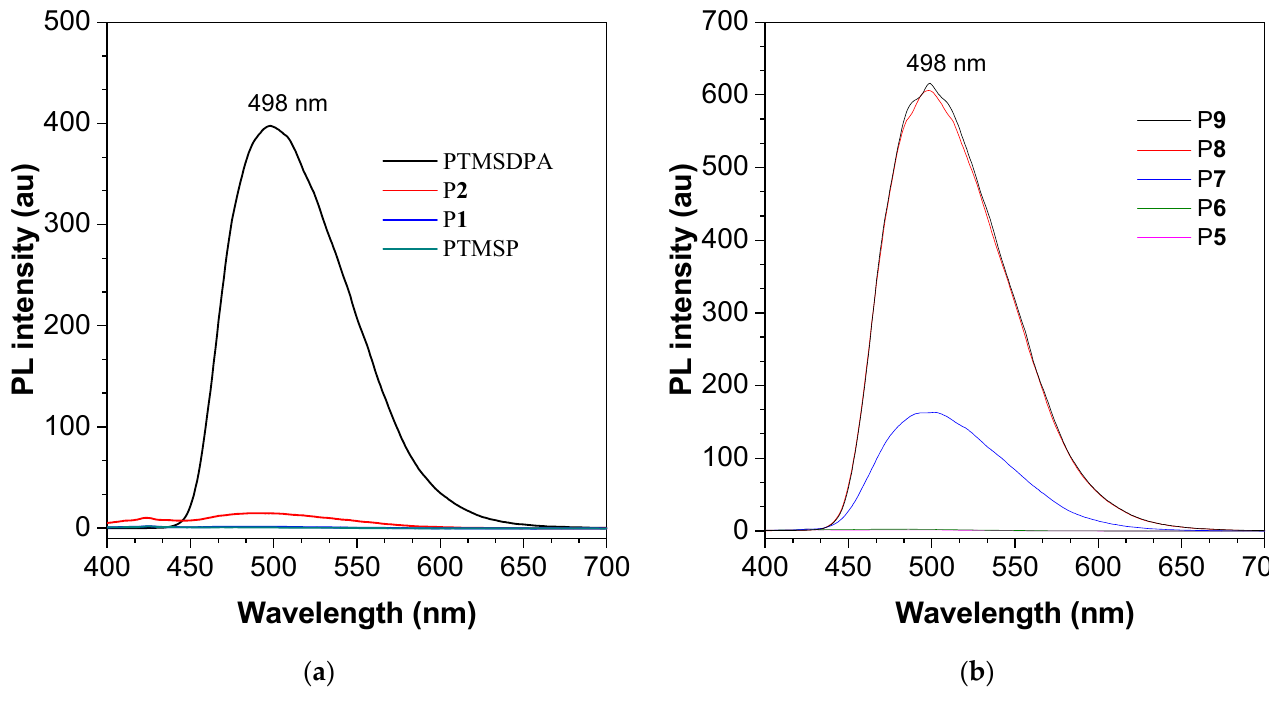
Figure 4. ( a ) PL spectra of PTMSP, P 1 , P 2 , and PTMSDPA. ( b ) PL spectra of P 5 , P 6 , P 7 , P 8 , and P 9 . The fluorescence spectra (Figure 5) of solid powders of polymers P 5 –P 9 were